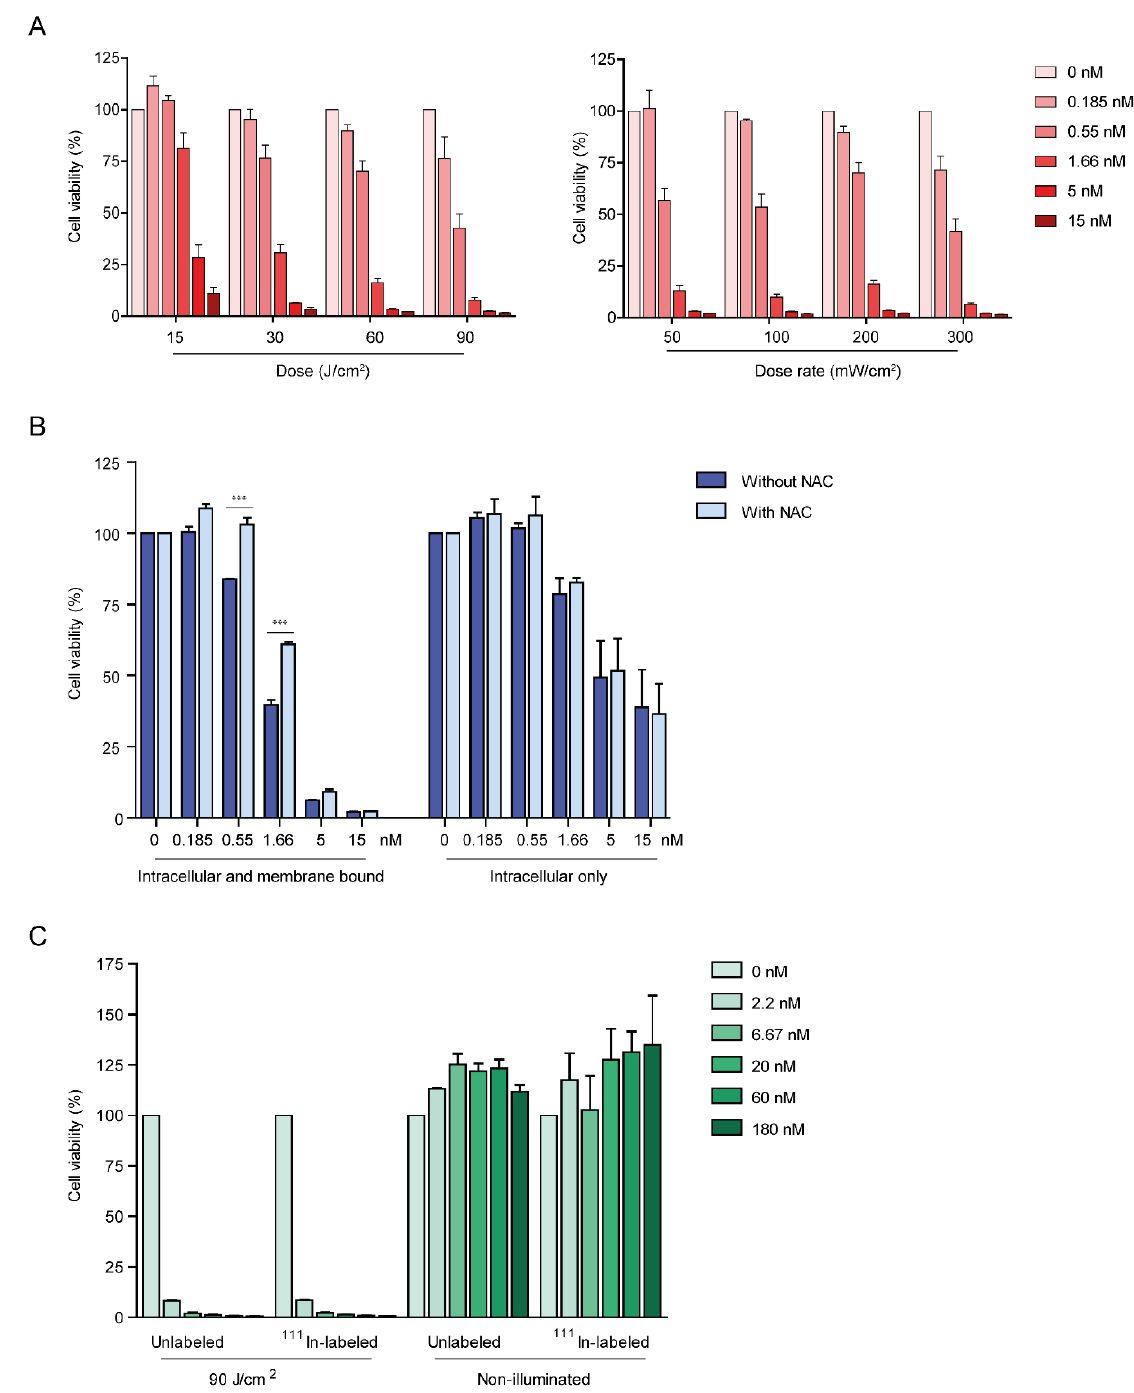
Figure 5. ( A ) DTPA-IRDye700DX-7D12 induces cell death of A431 cells upon illumination with varying light doses at a fixed light dose rate of 200 mW/cm 2 (left) and varying light dose rates (right) at a fixed dose of 60 J/cm 2 of 690 nm light. ( B ) Both internalized as well as membrane bound fractions of the conjugate contribute to light induced toxicity upon illumination with 60 J/cm 2 690 nm light at 200 mW/cm 2 . Incubation with singlet oxygen scavenger NAC partly inhibits the cytotoxic effect in cells containing both fractions, but not in cells containing only the intracellular fraction. ( C ) Both [ 111 In]In-DTPA-IRDye700DX-7D12 and unlabeled DTPA-IRDye700DX-7D12 induce toxicity with equal efficiency upon illumination with 90 J/cm 2 690 light at 200 mW/cm 2 , without illumination no toxicity is observed. Significance is determined with two-way ANOVA with post-hoc Bonferroni *** = p < 0.001.